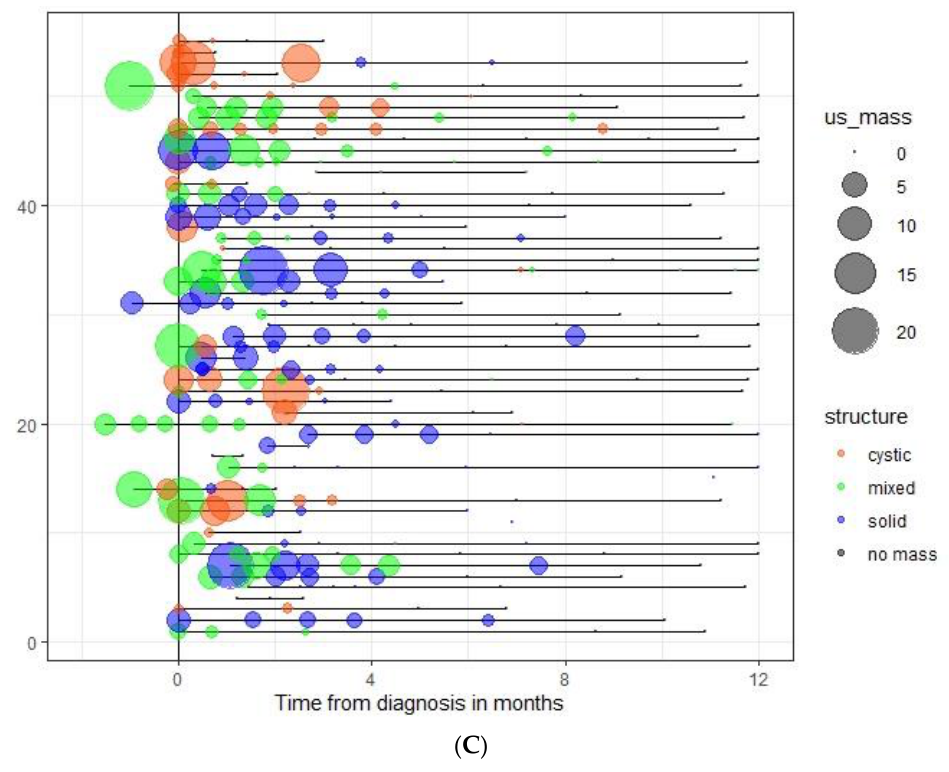
Figure 4. Swimmer/Bubble combined plot graph of patients with a SRM who underwent surgery and had ( A ) or did not have ( B ) an event. ( C ) Patients who achieved complete remission during the 48-week observation period. The plot displays evolution of the mass over time until surgery. Each patient is represented as a single horizontal line. Bubbles depict tumor volume (3D measurements in ml) for each US imaging monitoring point. Type of mass is color coded: orange (cystic), green (mixed) and blue (solid).